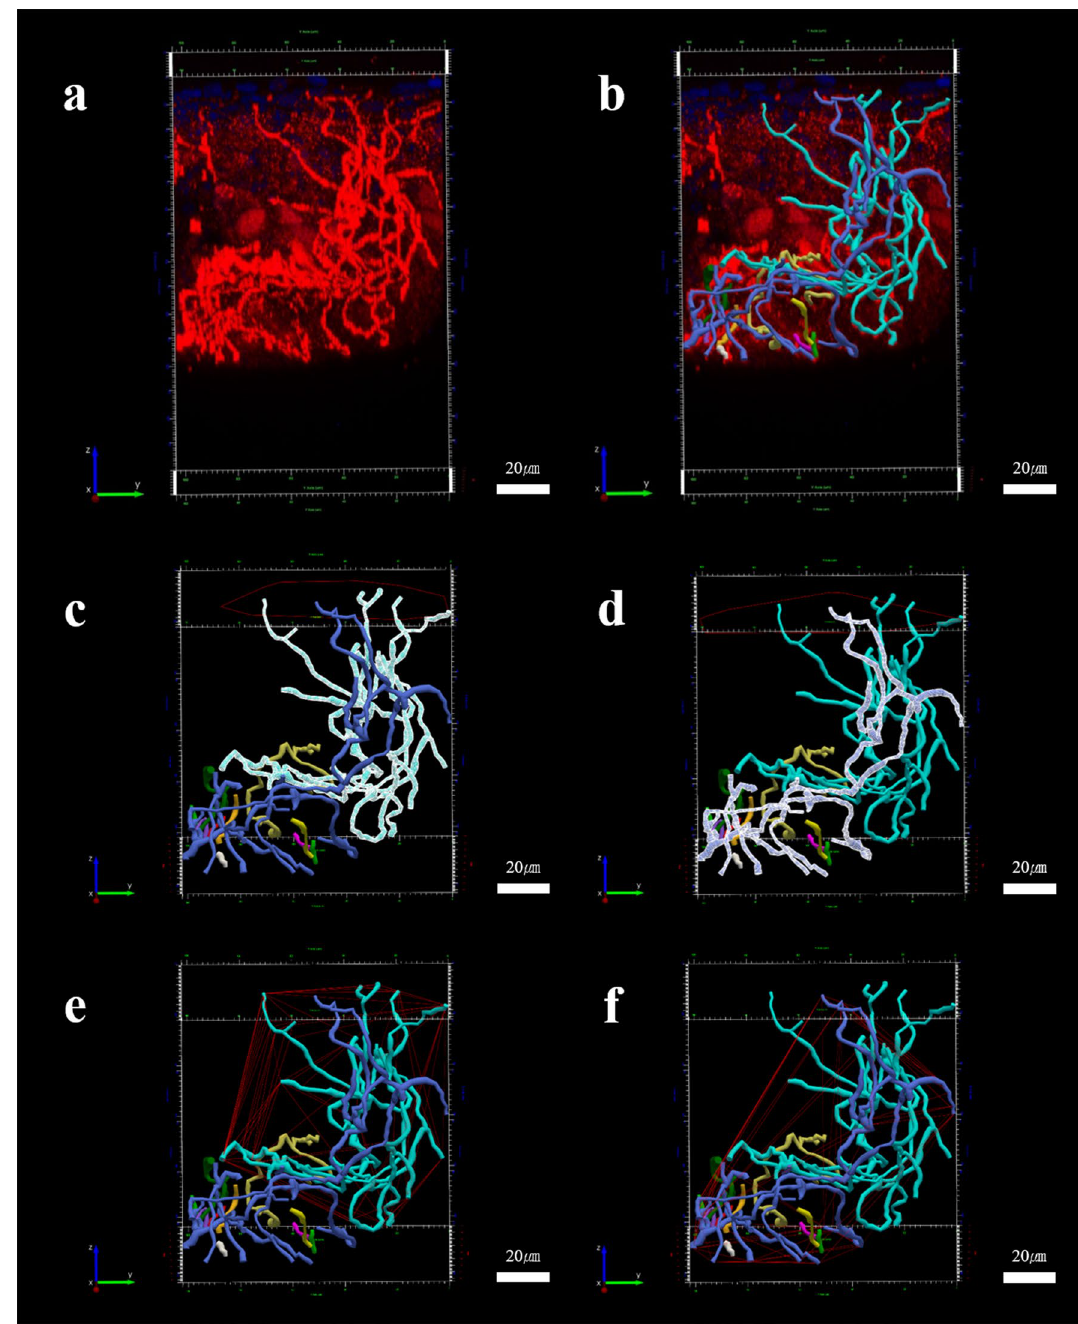
Figure 3. 3-D analysis of intraepidermal nerve fibers (IENFs) using software designed for neuronal reconstruction and quantitative analysis, N360. ( a ) The volume information of IENFs obtained from a 34-year- old participant was ( b ) semi-manually reconstructed using the tree tracing with directional kernels method. The reconstructed information was utilized to provide quantitative parameters, including not only conventional numbers of nerve fibers, but also true 3-D data such as nodes, ends, length, volume, complexity, tortuosity, and various angles. The 3-D evaluation also provided the specific field of branched structures controlling a given amount of physical space represented as ( c,d ) convex hull 2-D area and ( e,f ) convex hull 3-D volume. Each IENF, such as the ( c,e ) light blue-colored and ( d,f ) dark blue-colored reconstructed structure was separately analyzed to provide detailed individual morphological changes according to the natural aging process. Scale bar, 20